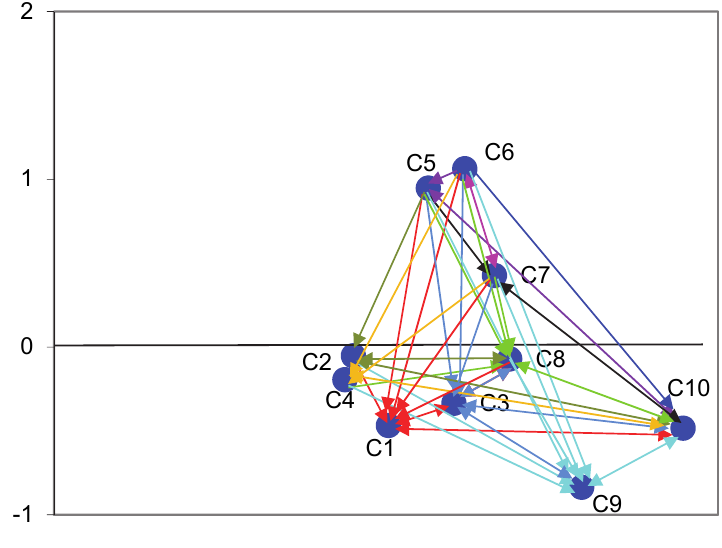
Fig. 4. Network relation